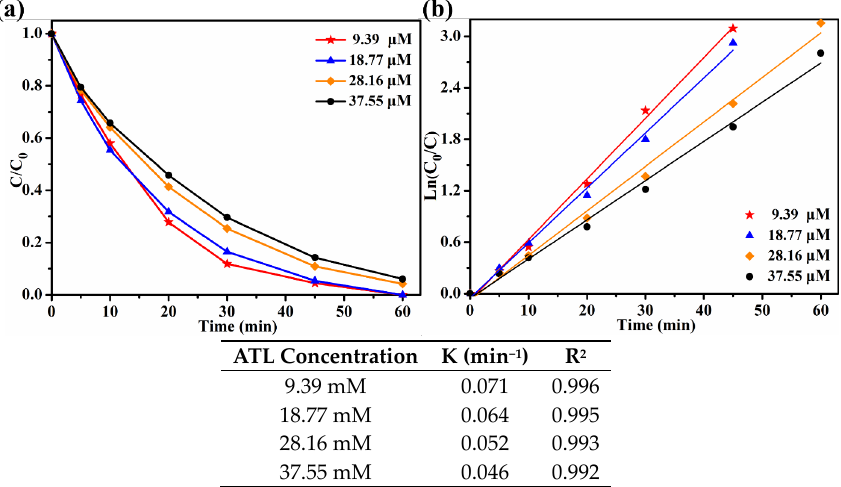
Figure 6. ( a ) Effect of varying initial concentration of ATL on ATL degradation ( b ) Pseudo- first-order model of ATL degradation. The initial mixed phase concentration of 2.0 g/L; pH: 7.6; temperature: 20 °C.